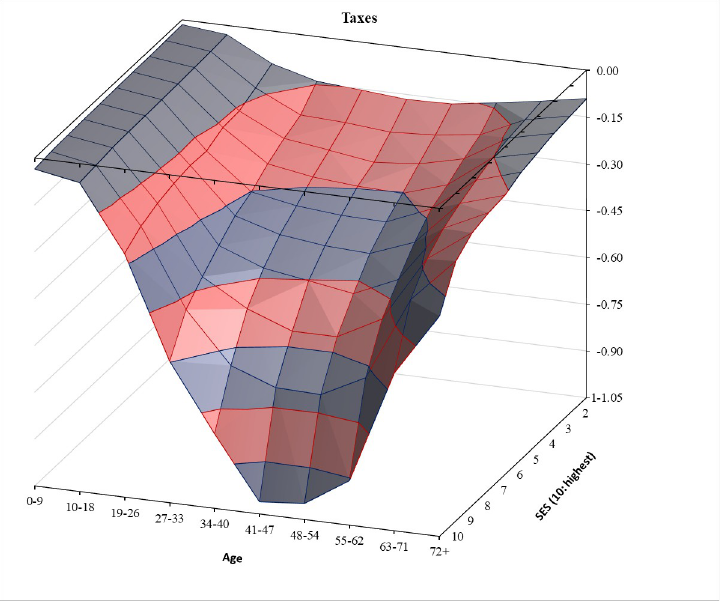
Fig 2. Per capita taxes and contributions financing welfare benefits by age and SES in the European Union. Sources and notes as in Fig 1.